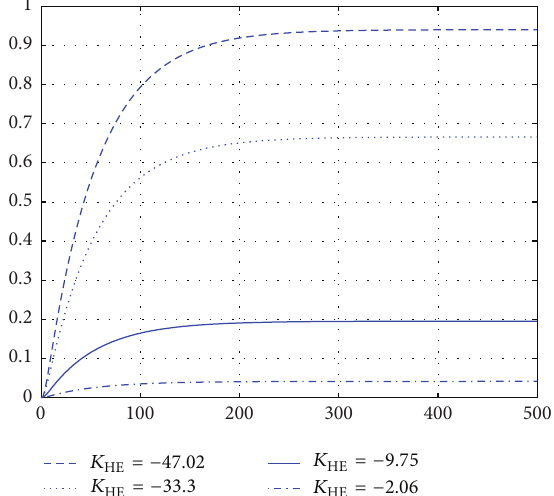
Figure 5: Step response of the HE for different values of linearized gains.